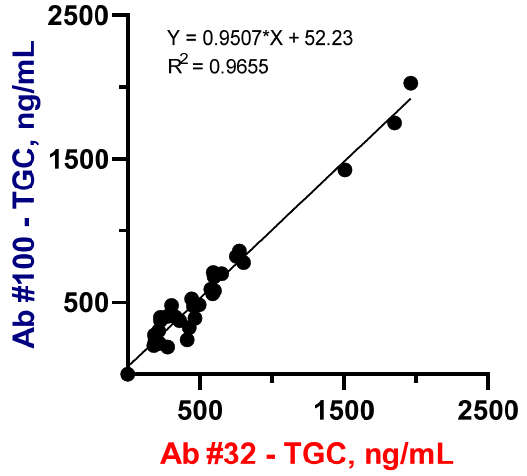
Figure 4. Correlation between TGC serum concentrations (n = 31) from 4 patients with sepsis ob ‐ tained using two assay systems: TC group ‐ specific ELISA (Ab#32) and TGC ‐ selective ELISA (Ab#100). Standard errors for slope and Y ‐ intercept were 0.03336 and 23.67,